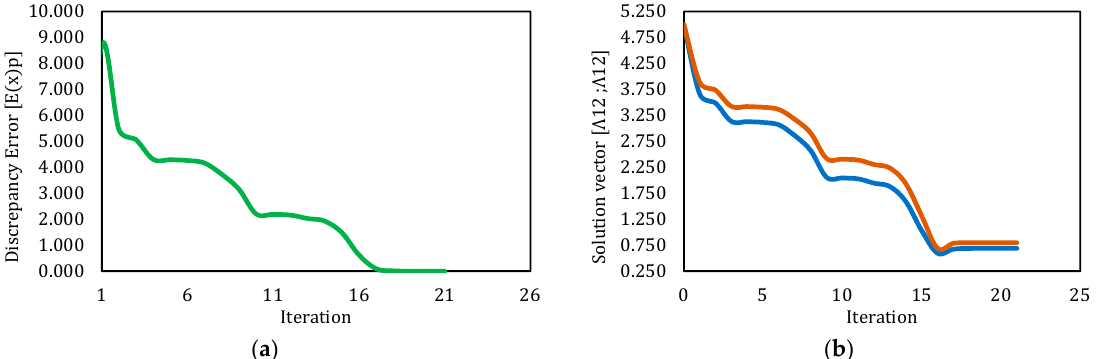
Figure 5. Behavior of discrepancy error and solution vector for Broyden’s method-simulation 1. ( a ) Behavior of discrepancy error respect to iterations. ( b ) Behavior of values for solution vector respect to iterations.